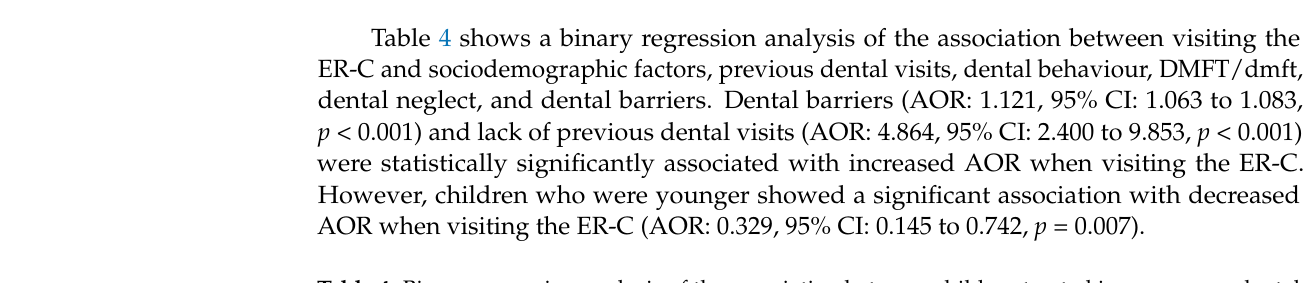
Table 4. Binary regression analysis of the association between children treated in emergency dental clinics and their sociodemographic factors, DMFT/dmft, dental neglect, and dental